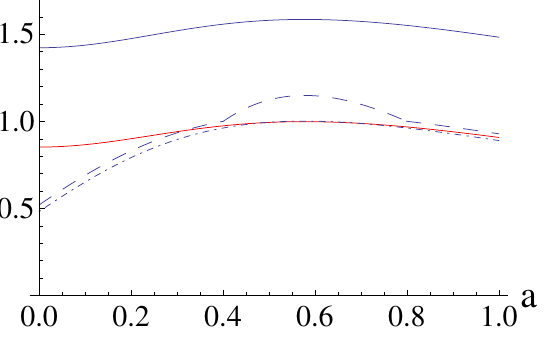
Figure 4. Lower and upper bounds of E α ( ρ ) for α = 0.6 where we have set x = 0.1. Red solid line is obtained by C 1 , the dash-dotted and dashed line is obtained by C 2 and C 3 , respectively. The blue solid line is the upper bound of E α ( ρ